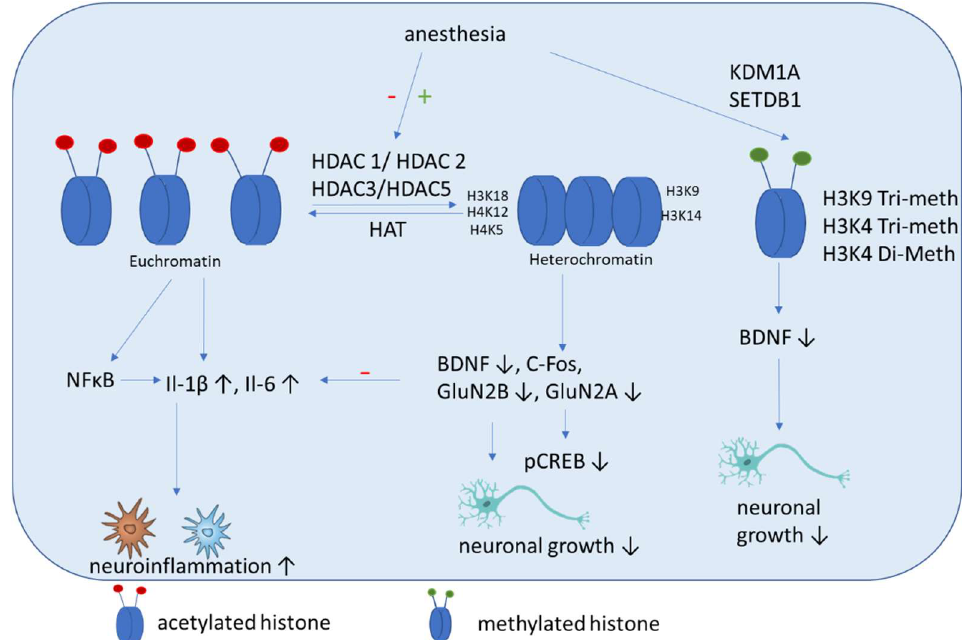
Figure 3. Schematic overview of the molecular mechanisms induced by anesthesia on histone modifications. Anesthesia can cause both a decrease of histone acetylation and an increase of HDAC activity. Histone deacetylation mainly causes an increase of inflammatory cytokines and a decrease of factors associated with neuronal growth, differentiation and survival of existing neurons. In addition, methylation (SETDB1) and demethylation (KDM1A) are induced by anesthesia, which can cause a decrease of BDNF.